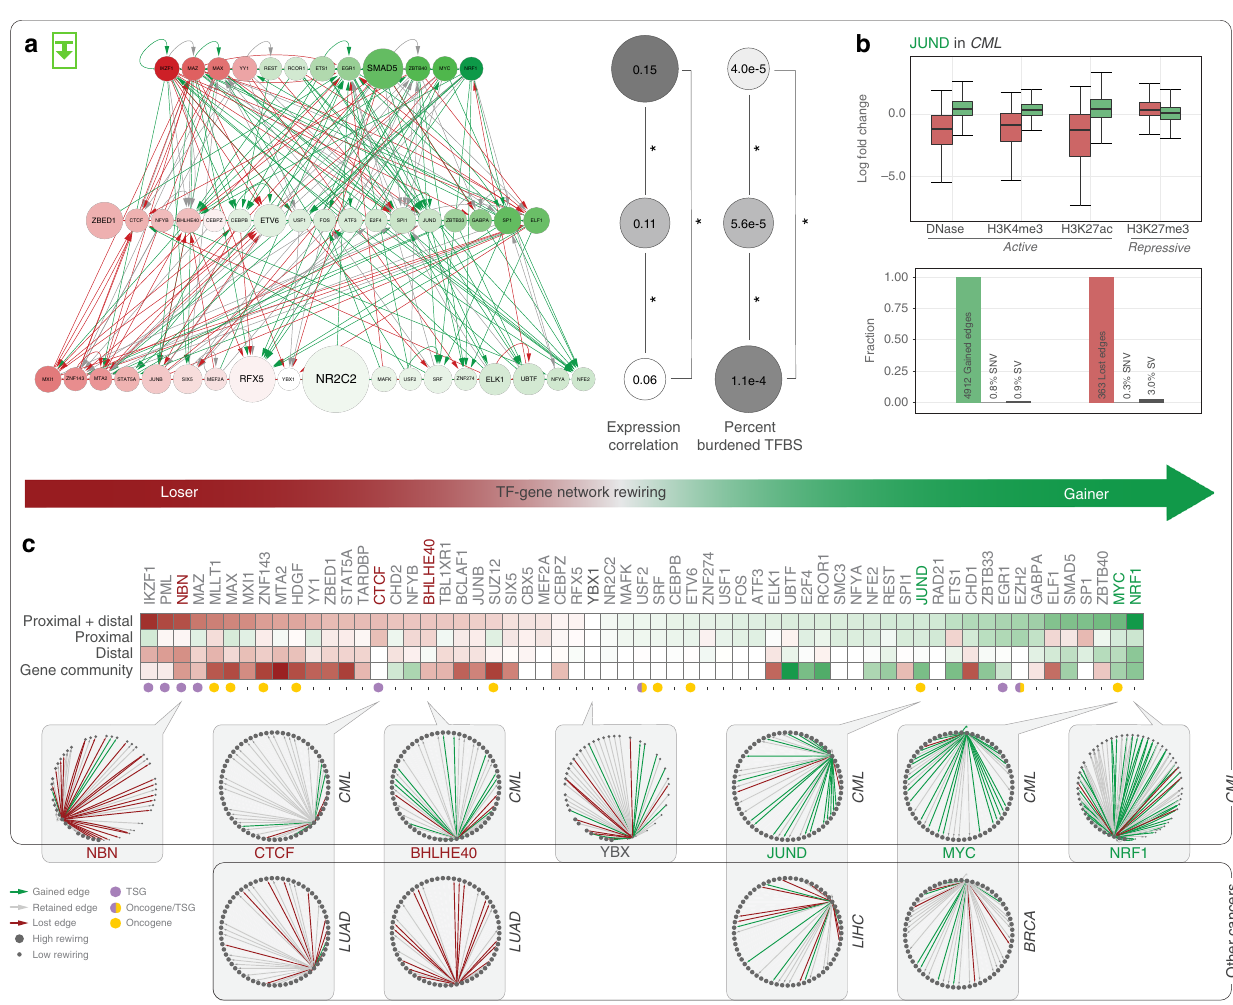
Fig. 3 TF-Gene network rewiring. Green and red arrows designate edge gain and loss, respectively. a Cell-type speci fi c network using K562 and GM12878: top layer TFs signi fi cantly drive tumor-normal differential expression; bottom layer TFs are more often associated with burdened binding sites. b JUND is a top edge-gainer in CML, and its targets demonstrate increased gene expression. However, few of its binding sites are affected by SVs or SNVs. c Rewiring index in CML by direct edge counts using both proximal and distal networks (top) and by gene community analysis (bottom). Comparisons to TF-gene rewiring networks in other cancers are also